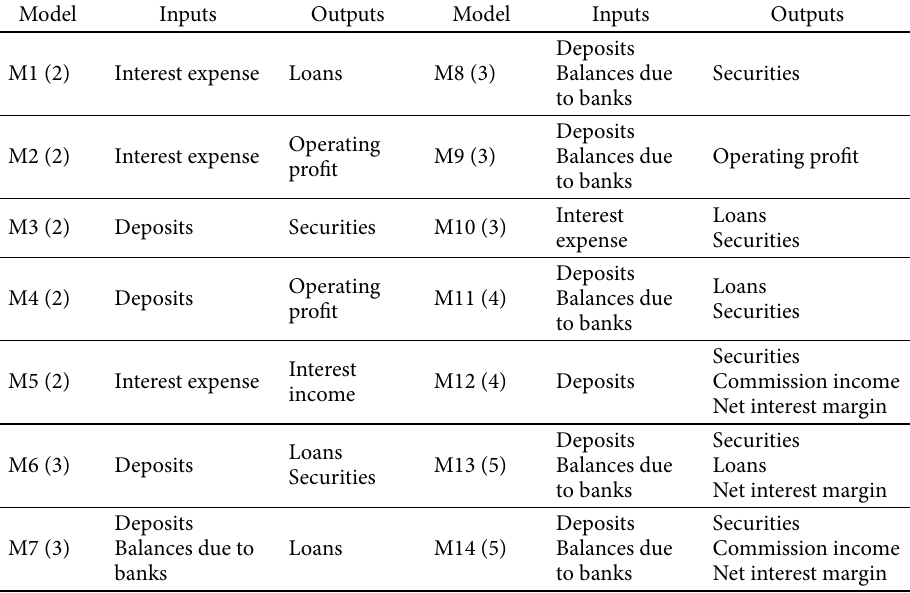
Table 5. DEA models with different input-output combinations (number of